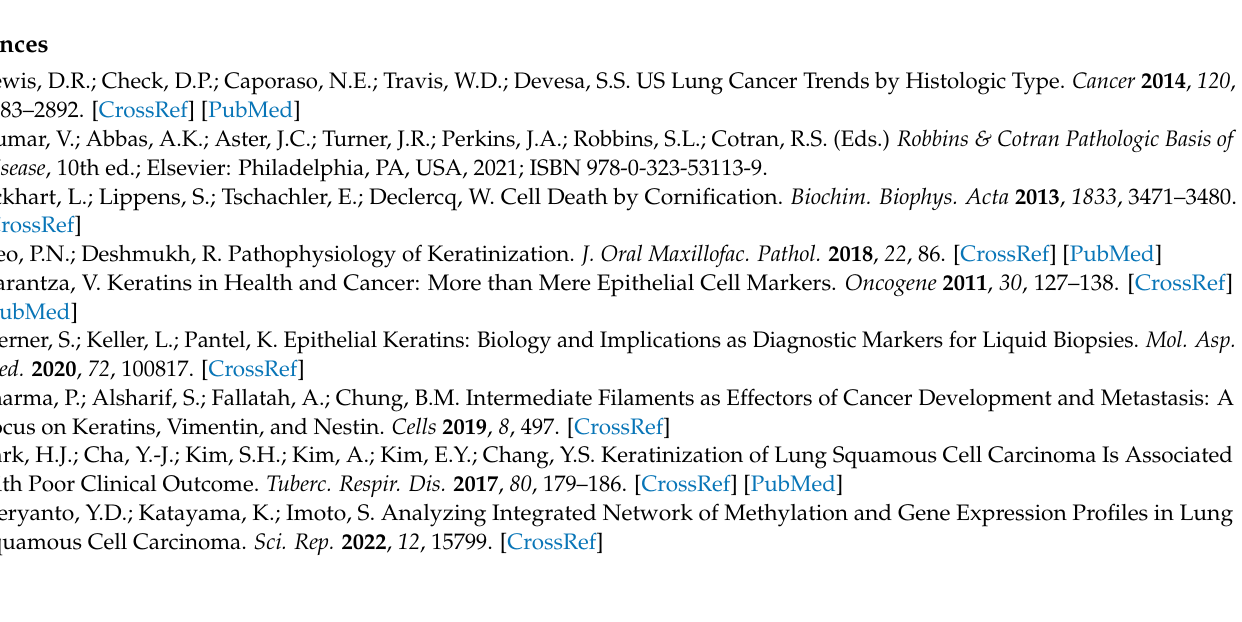
network. Table S3: The edge list of DEGs network. Table S4: The significantly hypomethylated gene–probe pairs in tumor samples with high keratinization. Figure S1: Pearson’s correlation between the TP63/SOX2 and keratins